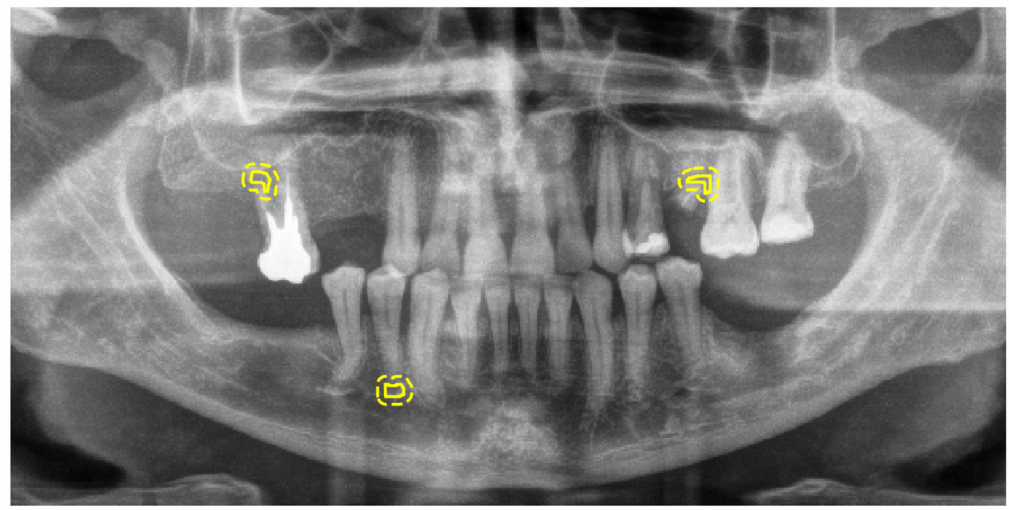
Figure A5. Example of a preprocessed panoramic radiographic image, selected from the test data set, with overlays of the ground truth contours (solid) and four-pixel error tolerance regions